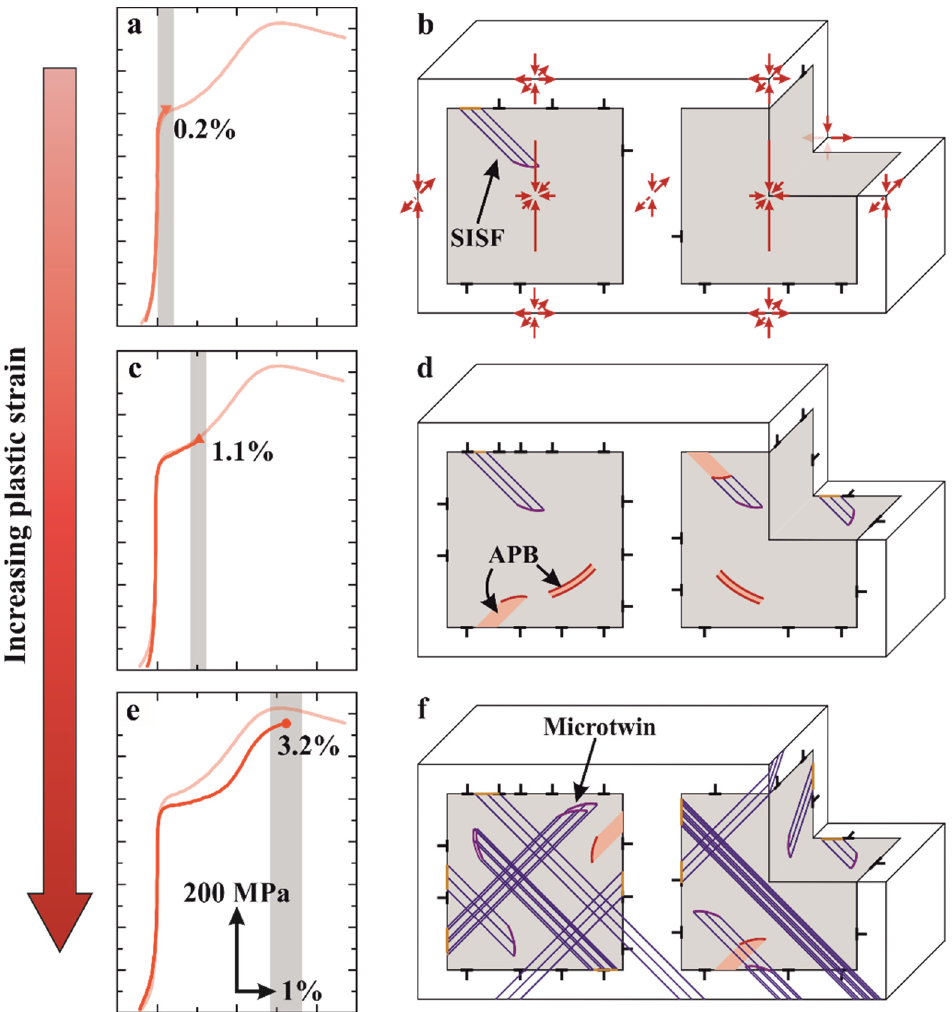
Figure 5. Schematic drawings of the evolution of the defect structure in VF60 at 950 °C; ( b ) Initially deformation starts in the horizontal γ channels; although, SISFs are occasionally observed in the γ′ precipitates. The superposition of the misfit stresses with the external stress is indicated; ( d ) With increasing plastic strain, deformation is still mainly confined to the γ channels. However, multiple shearing mechanisms are also active: shearing by APB ‐ coupled dislocation pairs, by single super ‐ partial dislocations, and by stacking faults connected to APBs. ( f ) After the γ matrix channels are filled, massive SSF ‐ based shearing occurs, which also leads to the formation of microtwins and is the reason for the high work hardening. In ( a , c , e ), the stress ‐ strain curves up to the discussed strain level are shown.